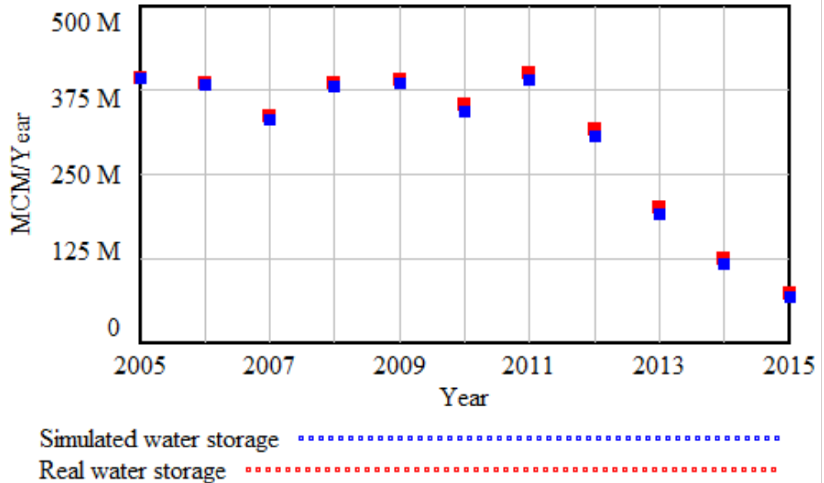
Figure 9. Comparison between real and simulated water storage in the Epit á cio Pessoa